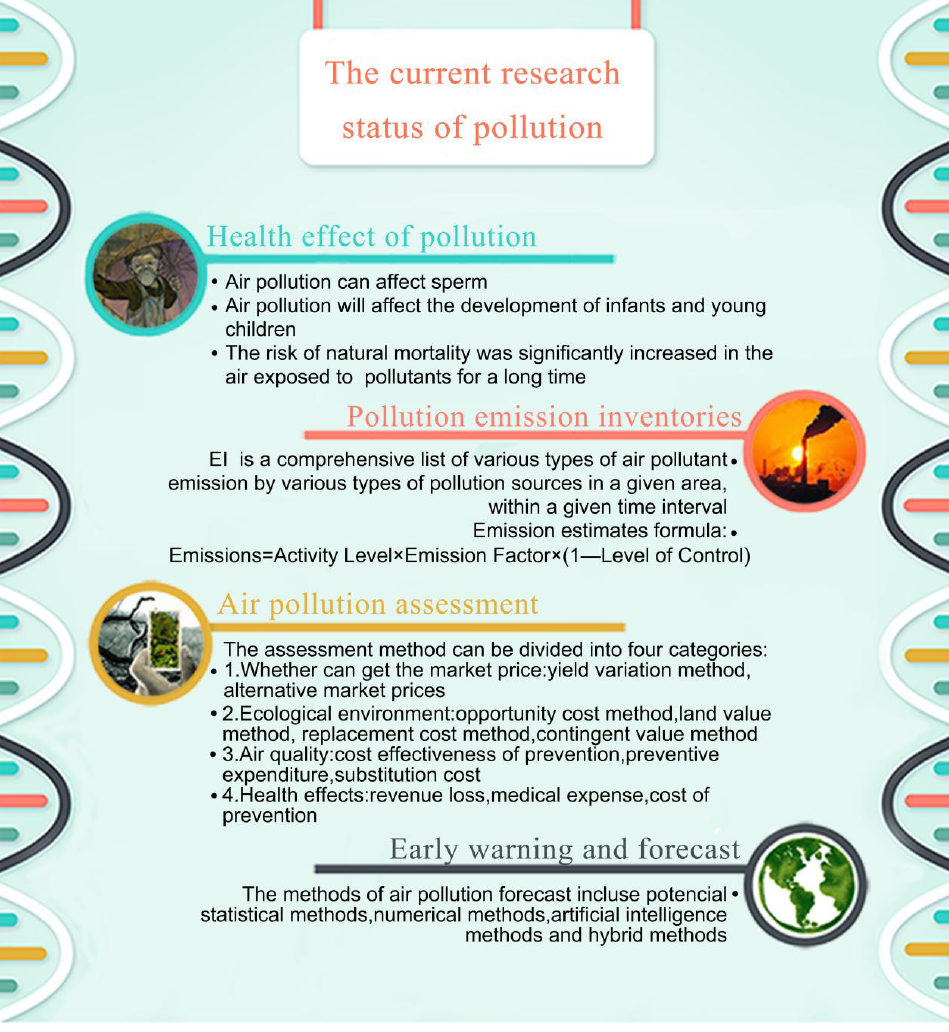
Figure 3. The current status of air pollution research.